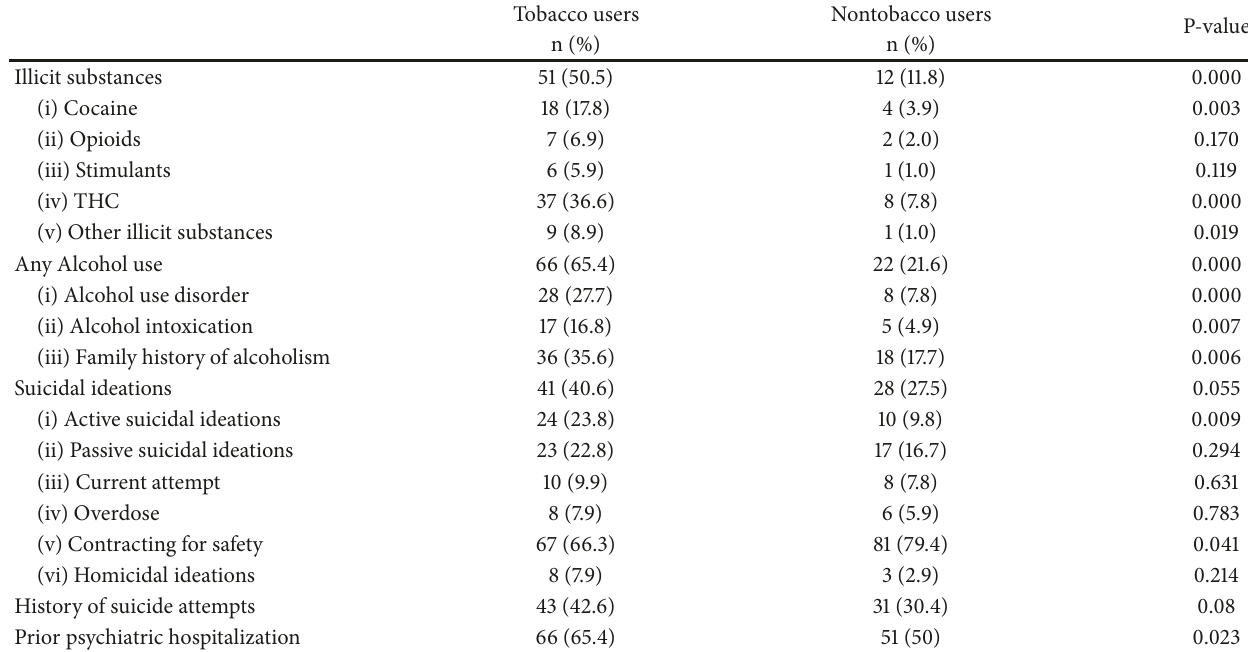
Table 2: Observations on tobacco users within